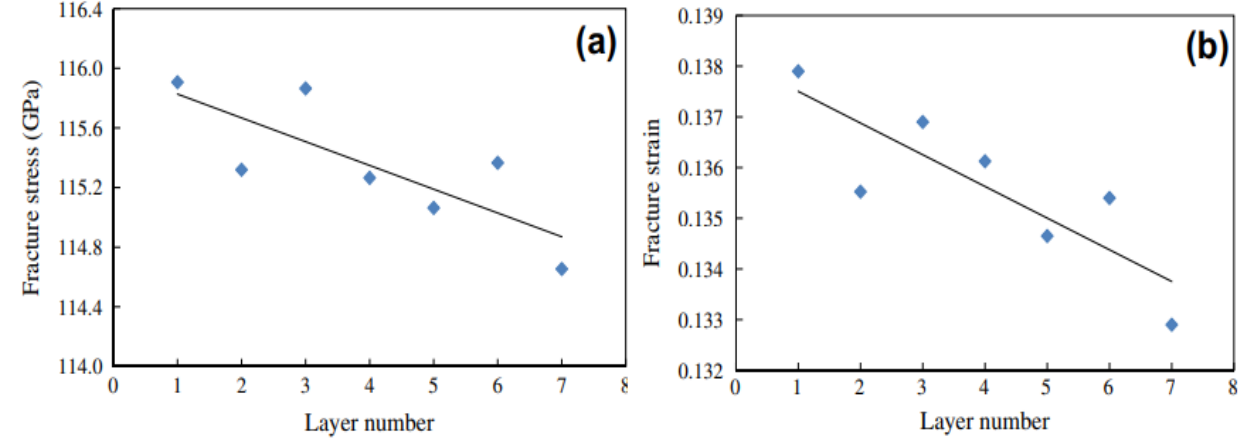
Figure 3. ( a ) The fracture stress and ( b ) fracture strain of mono- to few- to multi-layer graphene. Reproduced from [14] with the permission of Elsevier.